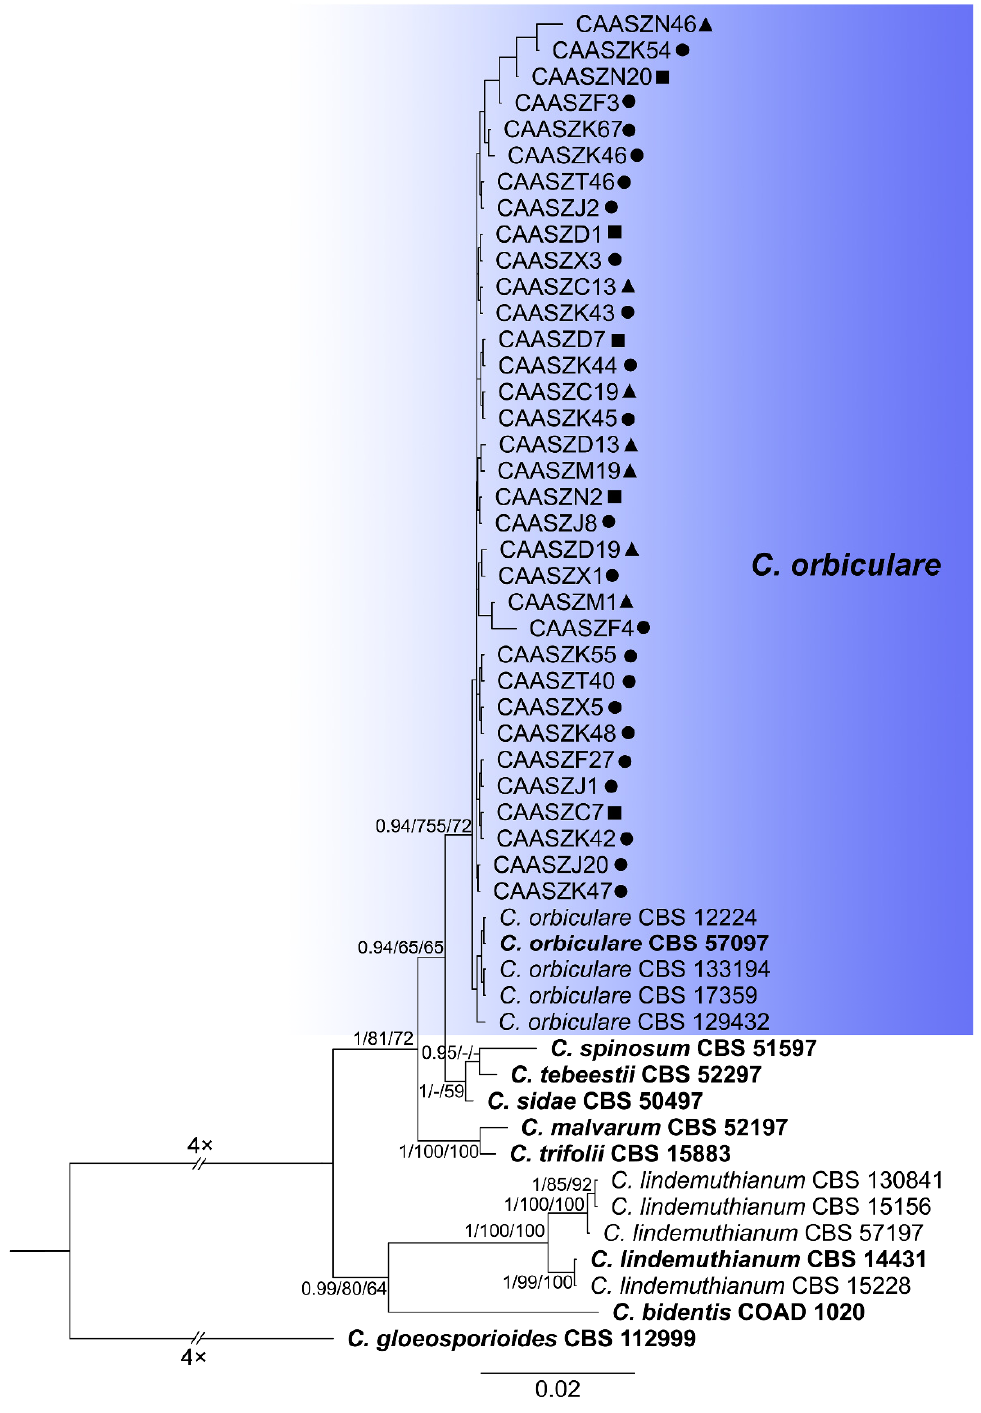
Figure 4. A Bayesian inference phylogenetic tree of 50 isolates in the C. orbiculare species complex. The species C. gloeosporioides (CBS 112999) was selected as an outgroup. The tree was built using concatenated sequences of the ITS, gadph , chs-1 , his3 , act , tub2 , and GS genes. Bayesian posterior probability (PP ≥ 0.90), MP bootstrap support values (MP ≥ 60%), and iqtree bootstrap support values (ML ≥ 50%) were shown at the nodes (PP/MP/ML). Ex-type isolates are in bold. Colored blocks indicate clades containing isolates from Citrullus lanatus in this study; triangles indicate strains isolated from leaves, rectangle indicate strains isolated from stems, circles indicate strains isolated from fruits. The scale bar indicates 0.02 expected changes per site.